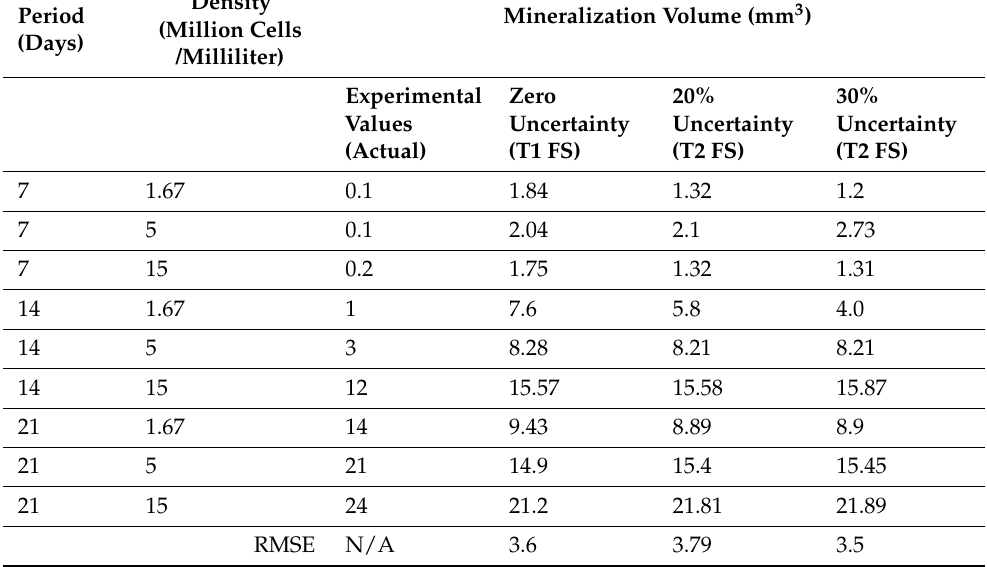
Table 4. Accuracy of Type-1 and Type-2 (20% and 30% uncertainty) Fuzzy